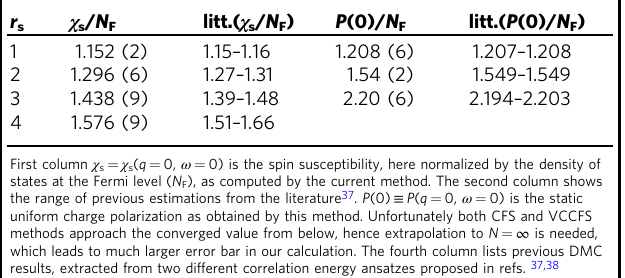
Table 1 Long wavelength values of spin and charge response r s